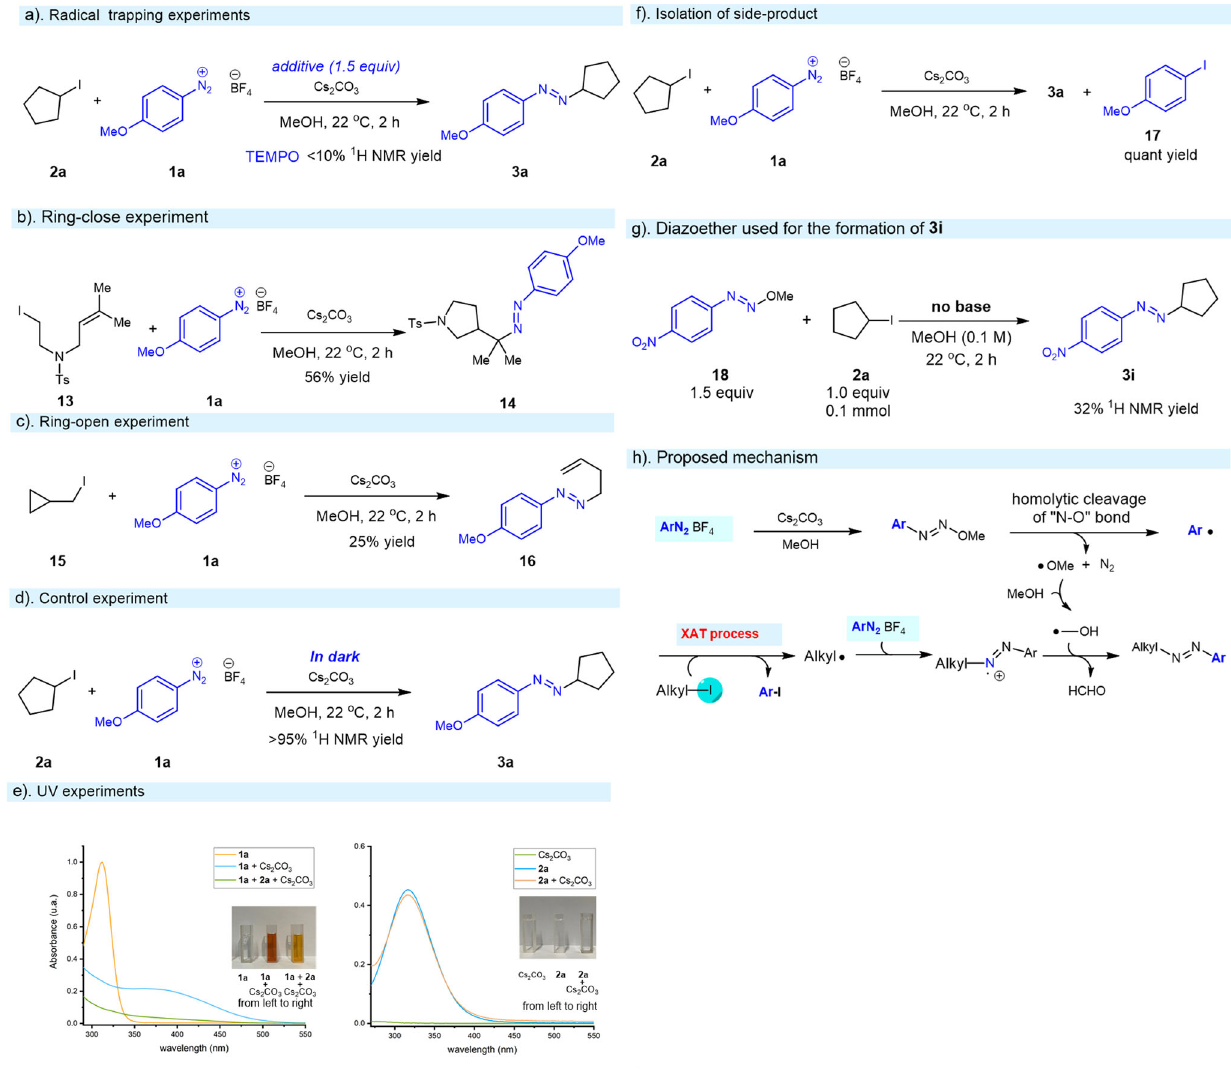
Fig. 7 | Mechanistic experiments. a Radical trapping experiment by employing TEMPO. b Radical clock reaction: ring-closed experiment. c Radicalclock reaction: